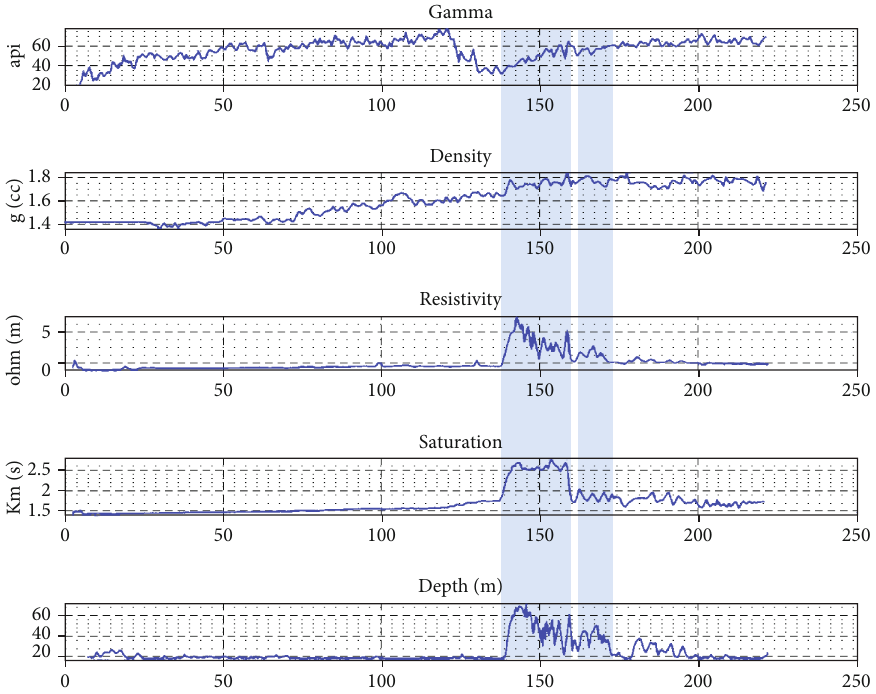
Figure 5: Original curves from well SH19; the blue shaded part indicates the layer of